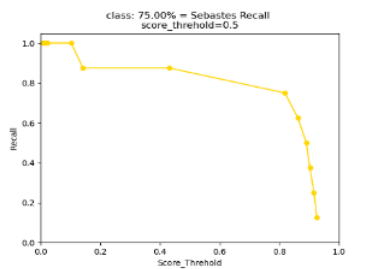
Fig. 5. Recall rate of box-jellyfish–YOLOX.